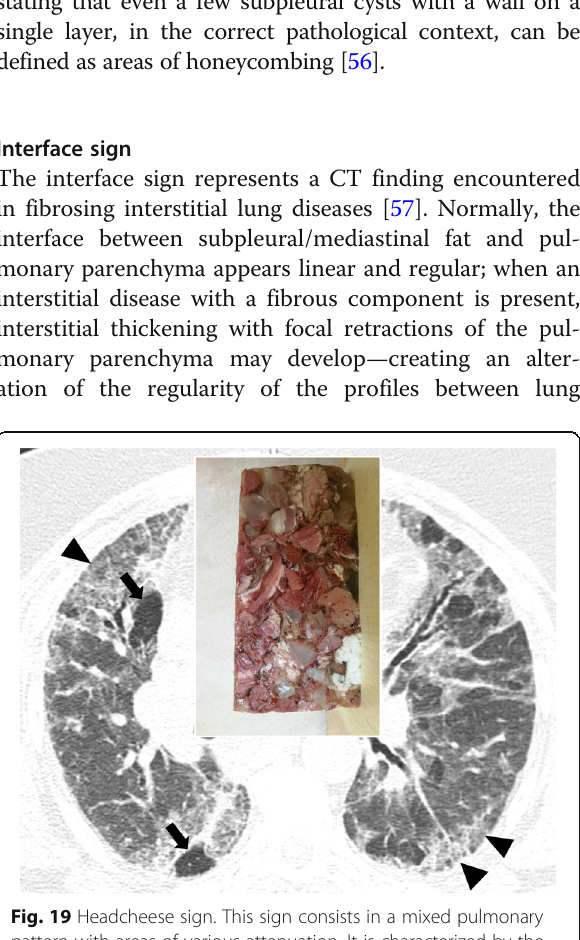
Fig. 18 Halo sign. The CT image shows the “ halo sign ” in a patient with angioinvasive aspergillosis: in the left lower lobe, it is possible to appreciate a round consolidation (black asterisk) with peripheral ground glass (white arrows), which suggests a hemorrhagic process. This ring or peripheral ground glass is similar to the sea ’ s appearance adjacent to an atoll